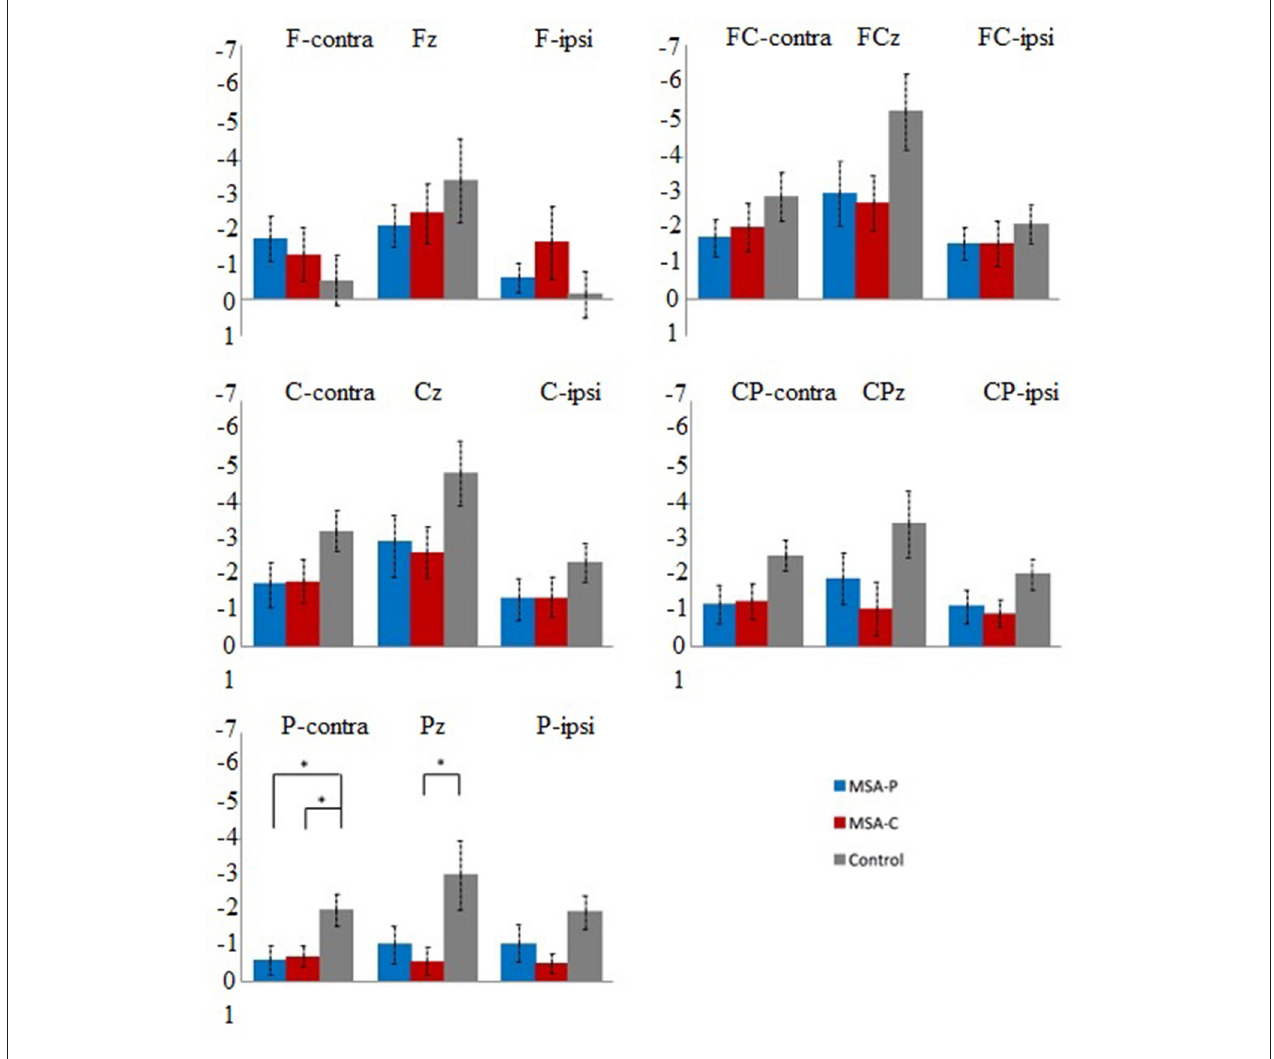
FIGURE 2 | Post-hoc comparisons of the mean late Bereitschaftspotential (BP) amplitude ( µ V) between patients with multiple system atrophy (MSA)-P (blue), patients with MSA-C (red), and healthy controls (black) at the 15 electrodes of interest. Error bars indicate standard errors. * p <